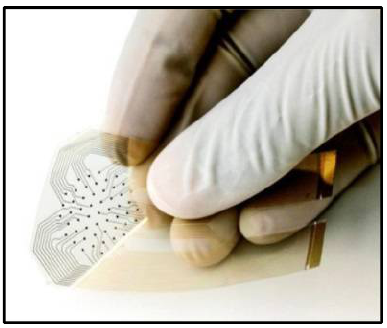
Figure 5. Flexible impedance sensor made via Inkjet Printing. Reprinted with permission from Springer Nature: Nature Communications reference [115] Copyright 2015.